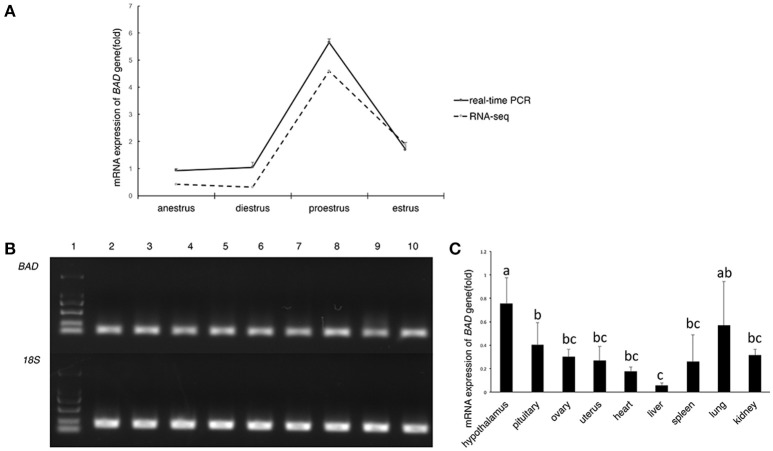
Expression profiling of BAD gene (A–C). (A)
BAD gene expression in sheep ovaries at different stage of oestrous cycle by RNA-seq and real-time PCR; (B) Expression level of BAD gene analyzed by semi—quantitative PCR. 1: Marker; 2-10: uterus, ovary, pituitary, hypothalamus, kidney, lung, spleen, liver, heart; BAD: BAD gene; 18S: 18S ribosomal RNA gene. (C) Relative expression level of BAD gene in different tissues of Small Tail Han sheep. Lowercase letters means significant differences (P < 0.05).